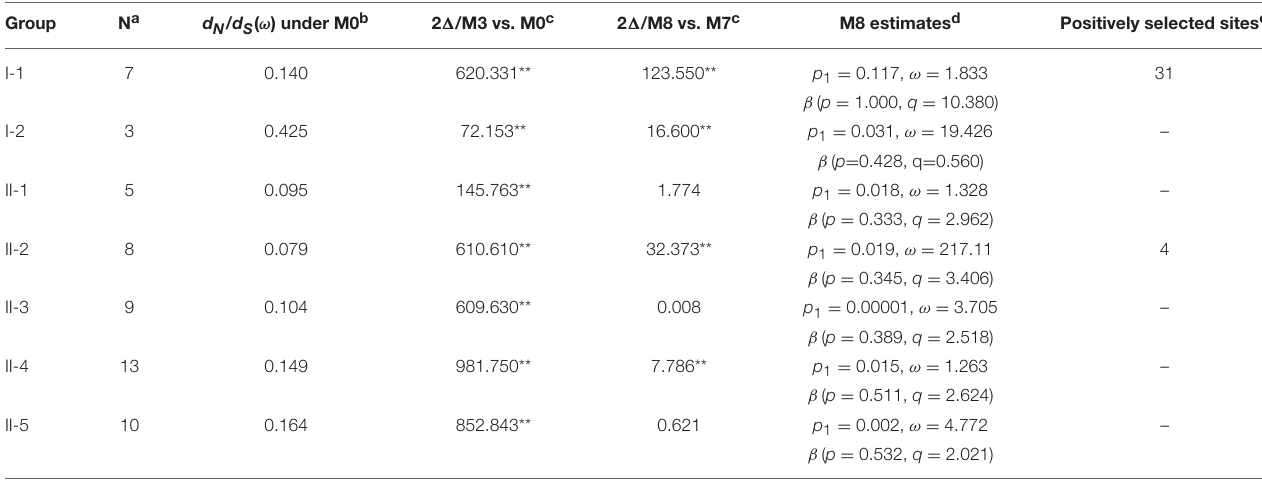
TABLE 3 | Detection of positive selection under site-specific